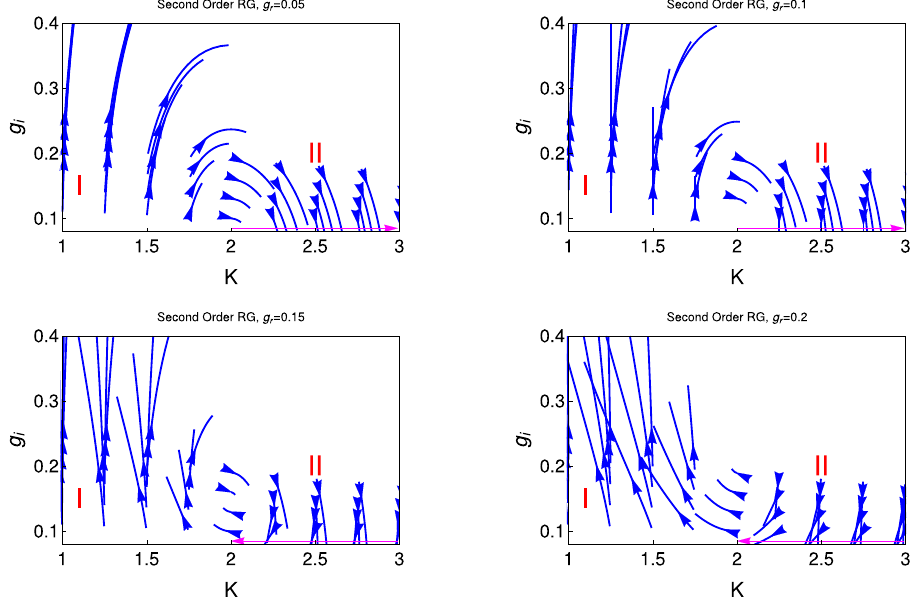
Figure 5. These figures show behaviour of RG flow lines, g i with K for four different initial values of g r ( 0 )( 0.05, 0.1, 0.15, 0.2 ) for the 2nd order RG process. The upper and the lower panels are respectively for the lower and higher values of g r ( 0 ) . We mark different regions of quantum phases by I, II. The magenta colour line represents the fixed line. Region I and II are respectively the superfluid and TLL